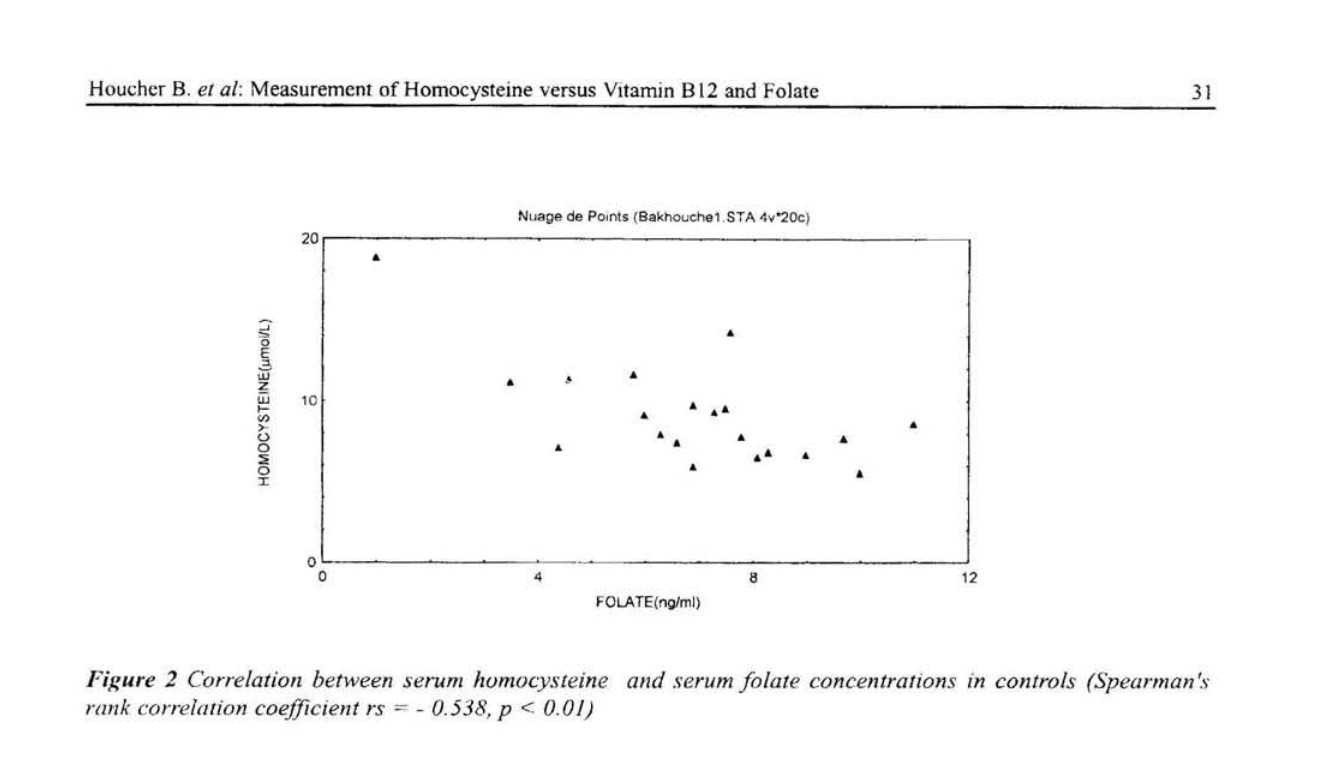
cysteine concentration of > 14 pmoi'L